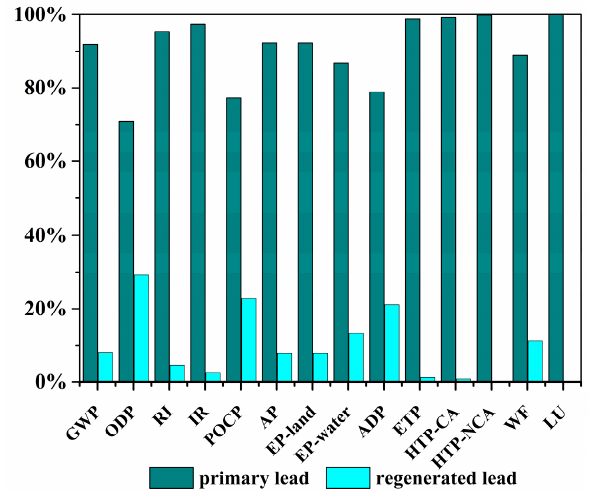
Figure 7. Comparative results of environmental burdens for primary lead and regenerated lead.